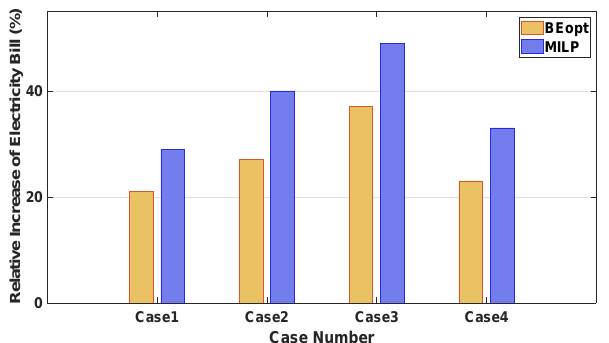
Figure 11. Comparison of a relative increase of the total electricity bill in the proposed DRL method using building energy optimization tool (BEopt) and mixed-integer linear programming (MILP) programs for four